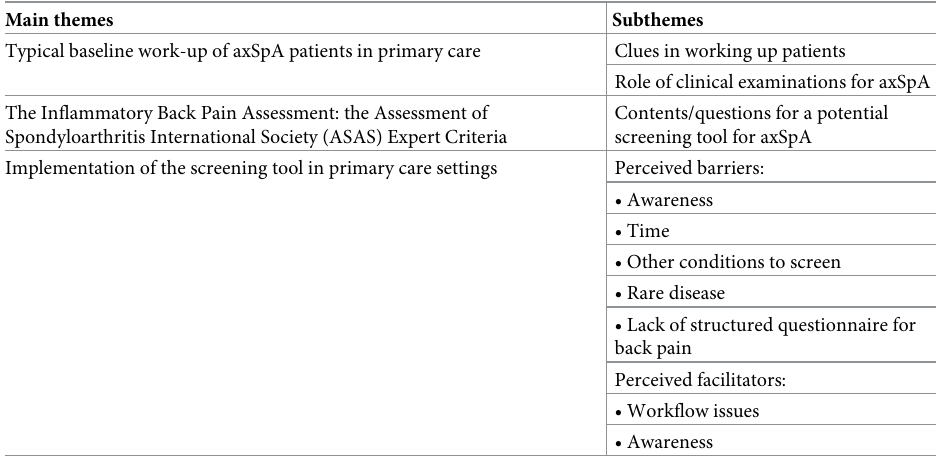
Table 2. Developed main themes and subthemes.